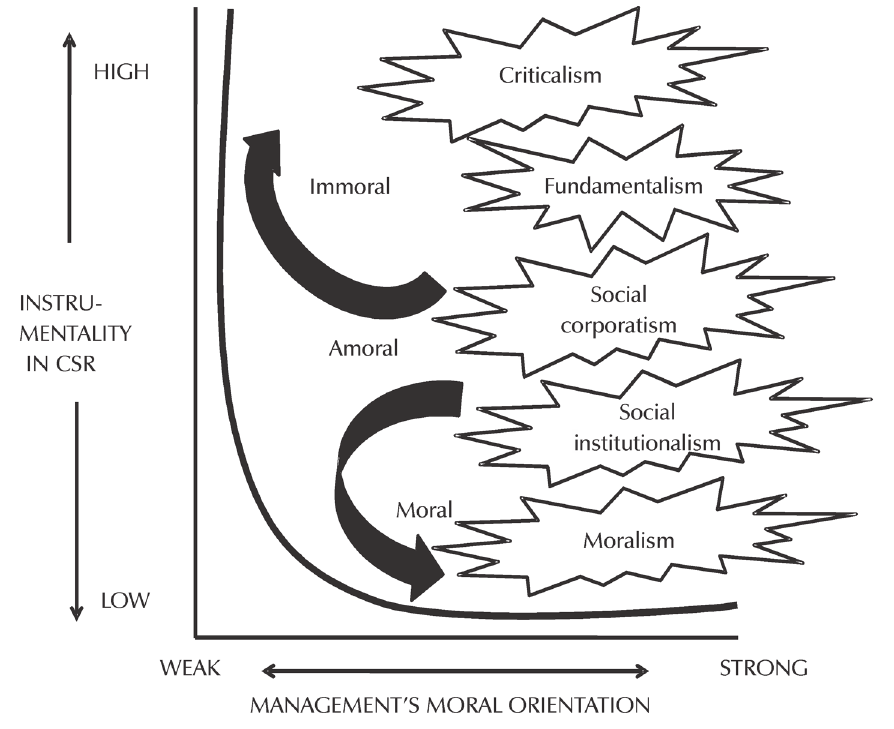
A heuristic device indicating interrelationships between approaches to CSR, corresponding levels of instrumentality in CSR and managerial moral